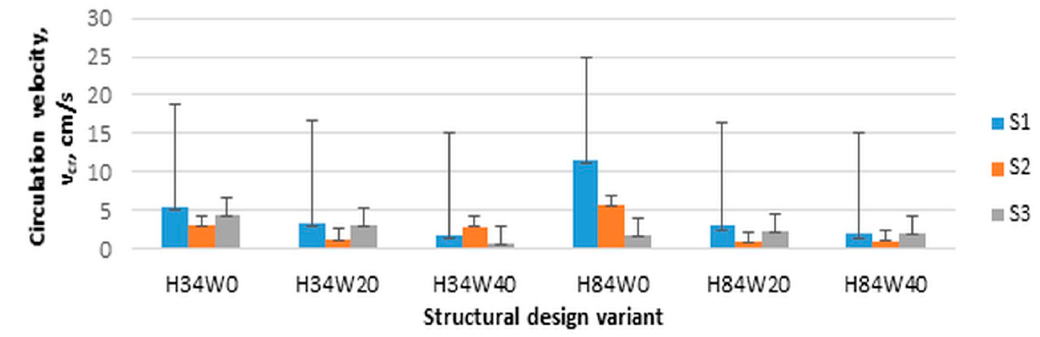
Figure 7. Circulation velocity v cr of liquid in the reactor in different measurement zones; point M2.